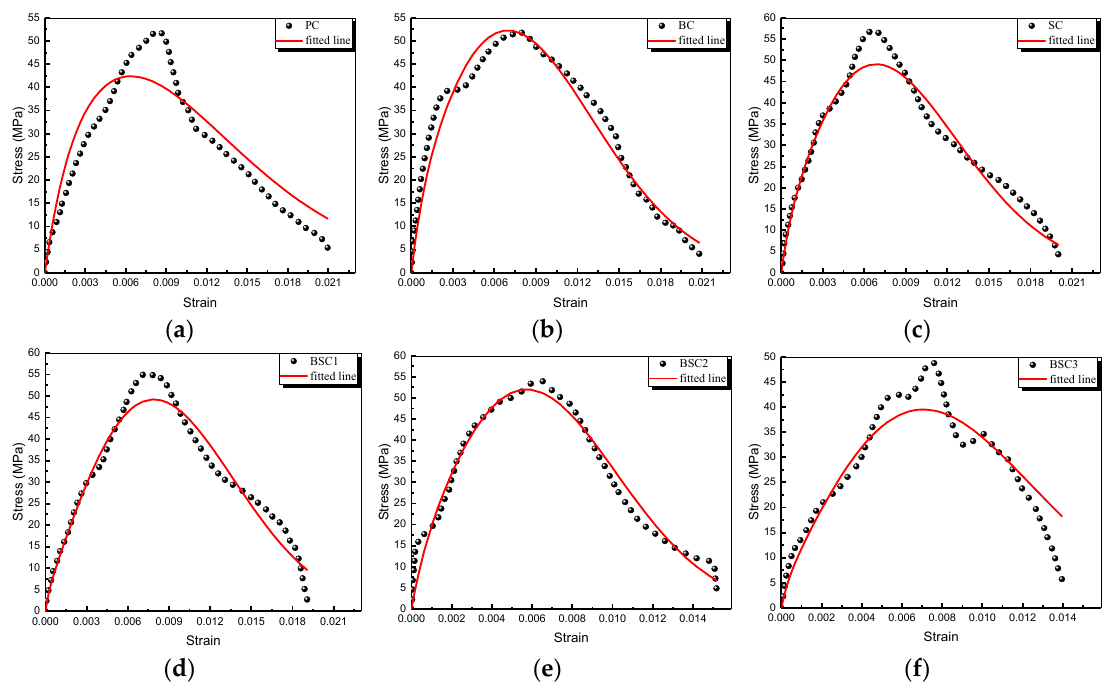
Figure 19. Experimental and fitted stress–strain curves with di ff erent w / c ratios: ( a ) PC; ( b ) BC; ( c ) SC; ( d ) BSC1; ( e ) BSC2; ( f ) BSC3. Table 7. The fitted parameters of BSFRC with di ff erent fiber hybrid